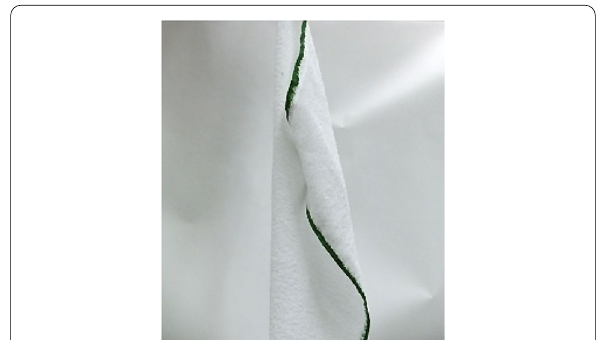
Fig. 2 Some methods that try to locate specific points like corners; however, cloth tends to curl over, which can hide these points. The green lines are the painted physical edges. Physical edges are detected in the RGB image using color segmentation and are used to generate labels. During training, we only use the depth image, and the neural network never receives this color information